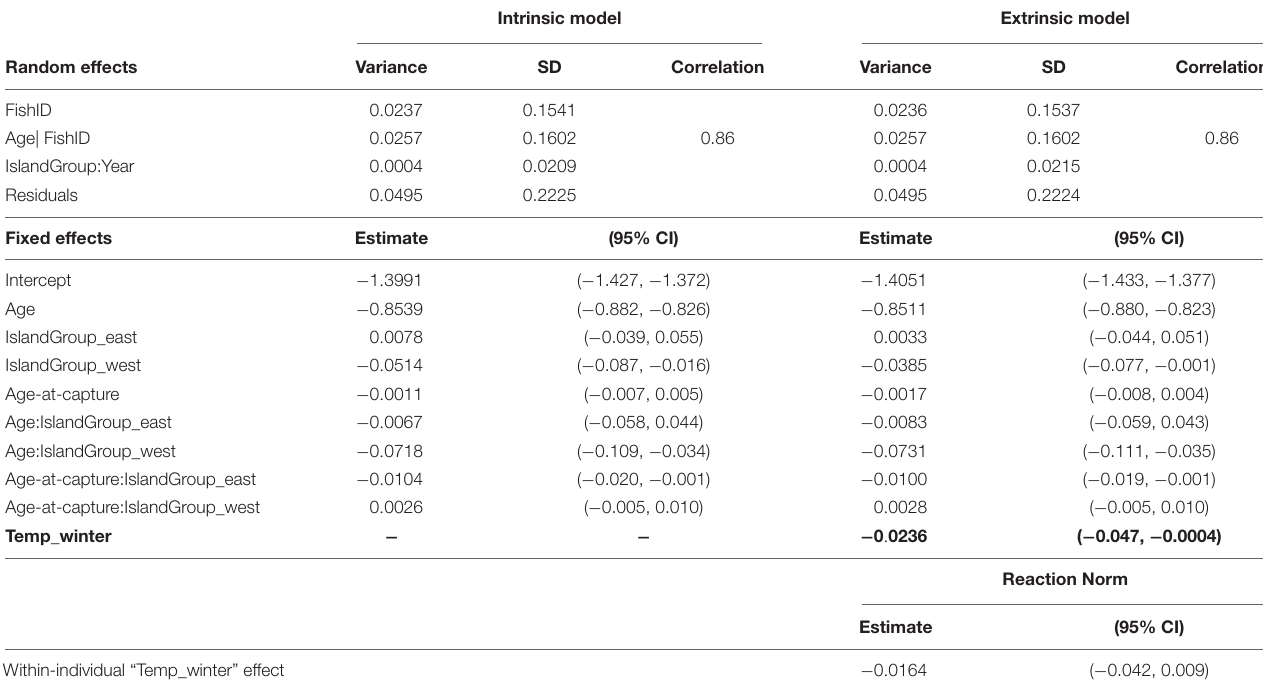
TABLE 2 | Final Pagellus bogaraveo otolith growth model, with selected extrinsic fixed effects in bold.